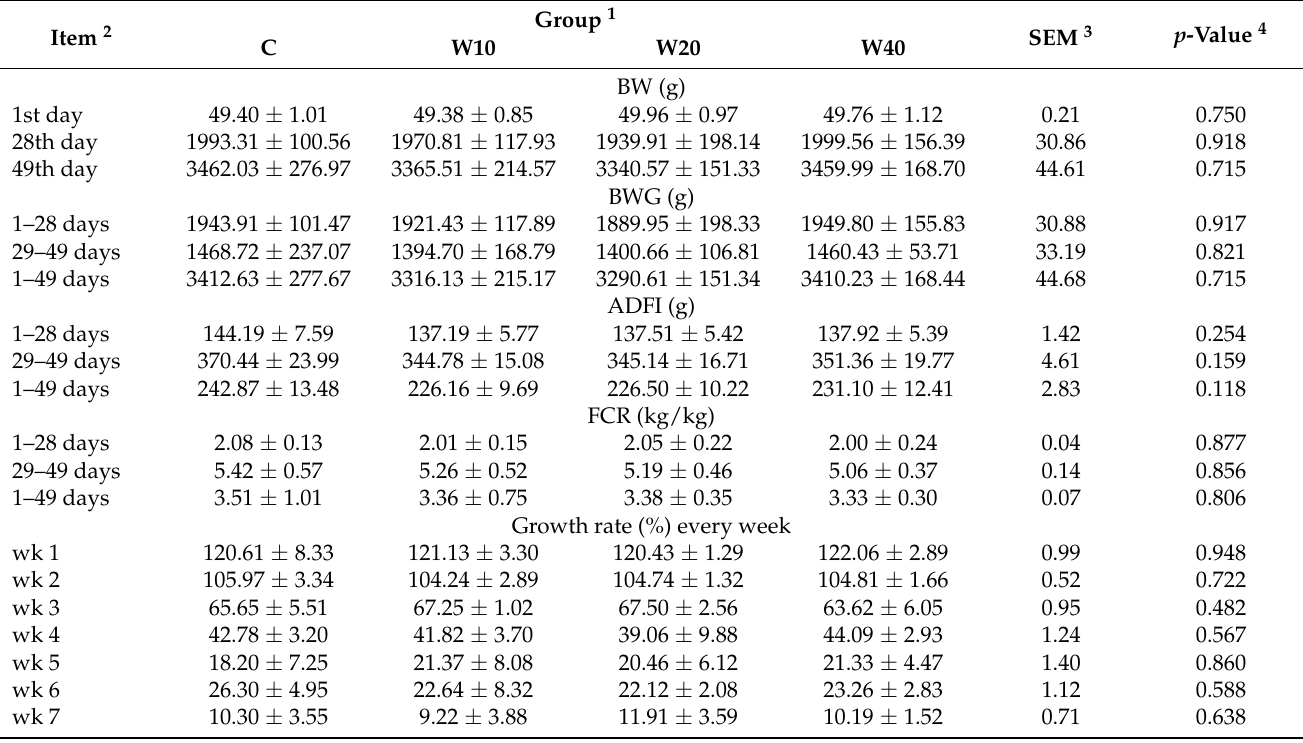
Table 2. Growth performance of broiler ducks during 7 weeks of rearing.